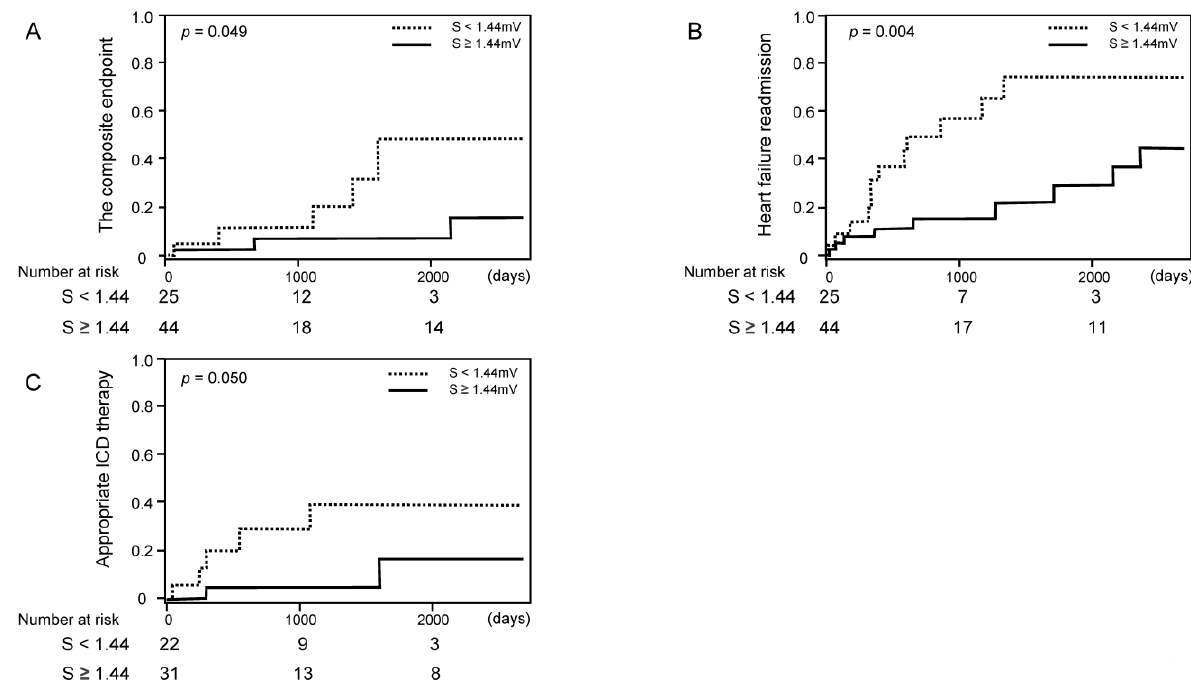
Figure 3. Cumulative incidence of clinical events stratified by the cutoff of S-wave amplitude (( A ) cardiovascular death; ( B ) heart failure readmission; ( C ) appropriate ICD (implantable cardioverter defibrillator) therapy). Table 4. Multivariate regression analyses for clinical